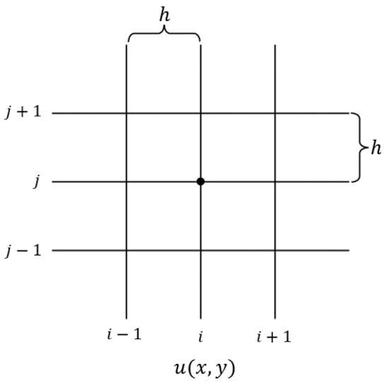
A section of grid on which a scalar field u(x, y) is defined, illustrating derivatives by convolution operations.